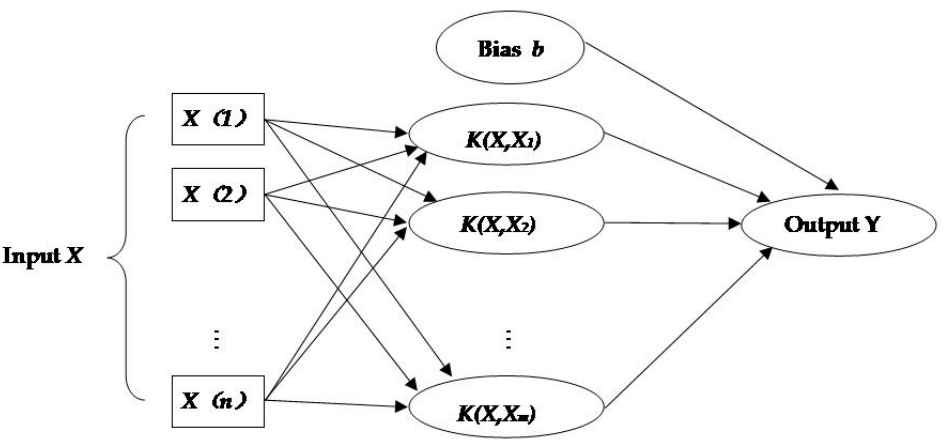
Figure 12. The normal structure of support vector machine.